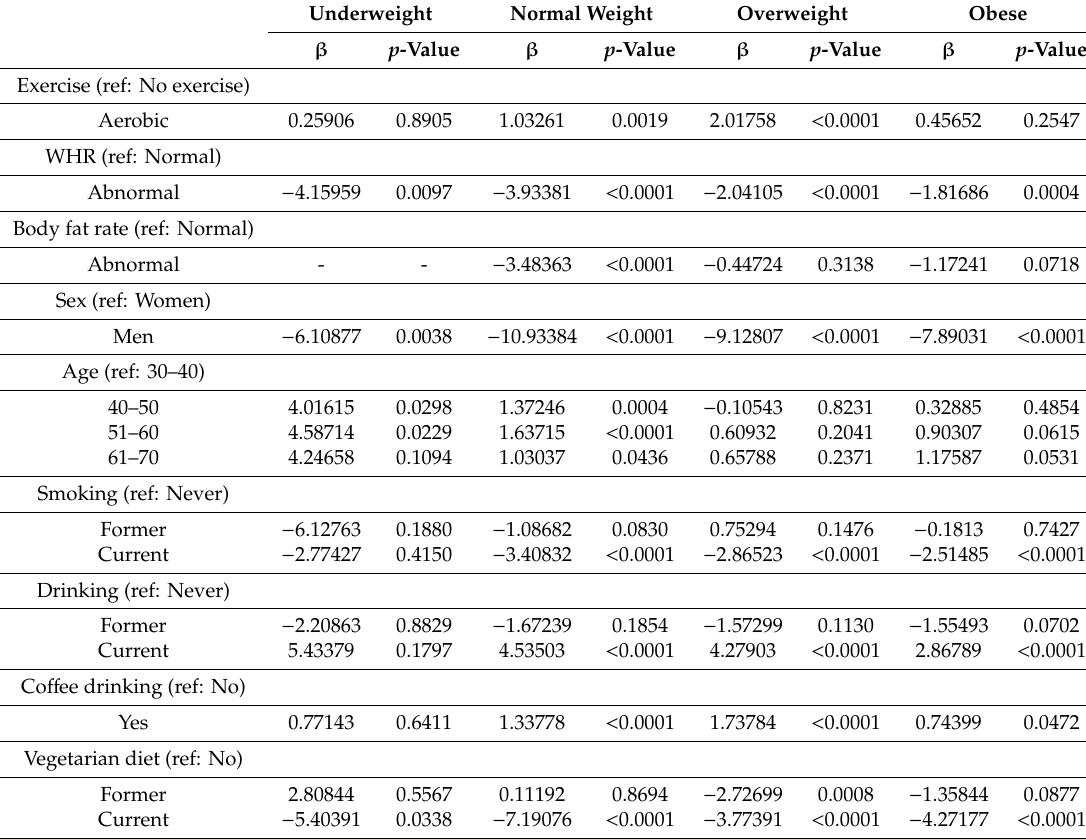
Table 5. Multiple linear regression showing the e ff ect of aerobic exercise on HDL-C based on BMI. Underweight Normal Weight Overweight Obese β p -Value β p -Value β p -Value β p -Value